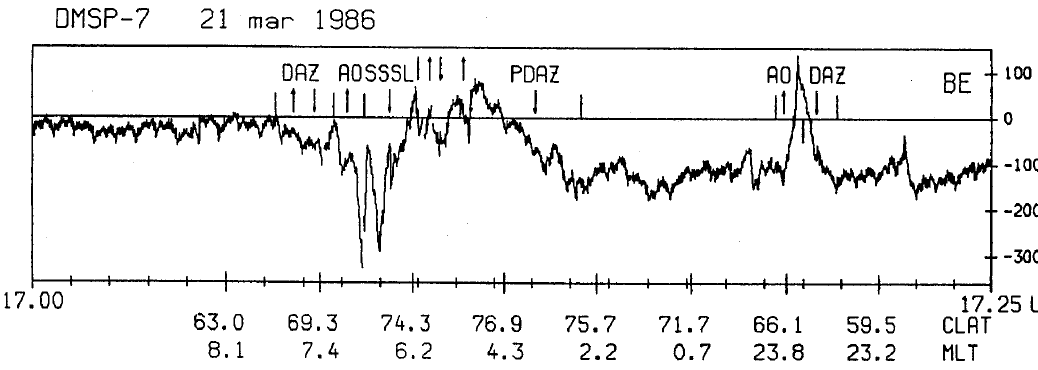
Fig. 11. The same as Fig. 4, except for 21 March 1986, 1700–1725 UT.